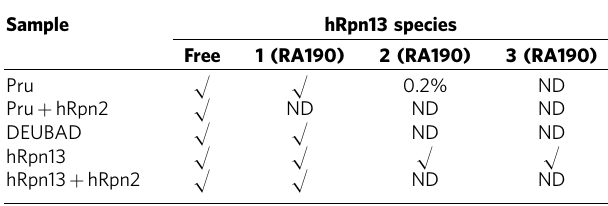
Table 3 | Detected hRpn13 species by LC-MS for indicated